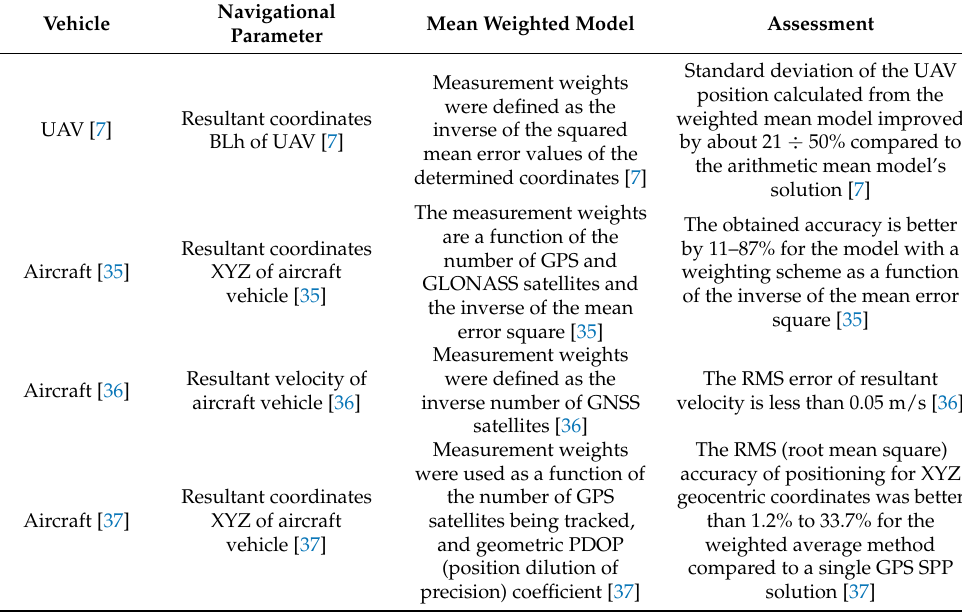
Table 1. The characteristic of the mean weighted model in research work in the aeronautical area. Navigational Vehicle Mean Weighted Model Assessment Parameter Standard deviation of the UAV Measurement weights position calculated from the were defined as the Resultant coordinates weighted mean model improved UAV [7] inverse of the squared by about 21 ÷ 50% compared to BLh of UAV [7] mean error values of the the arithmetic mean model’s determined coordinates [7] solution [7] The measurement weights The obtained accuracy is better are a function of the Resultant coordinates by 11–87% for the model with a number of GPS and Aircraft [35] XYZ of aircraft weighting scheme as a function GLONASS satellites and vehicle [35] of the inverse of the mean error the inverse of the mean square [35] error square [35] Measurement weights Resultant velocity of were defined as the Aircraft [36] aircraft vehicle [36] inverse number of GNSS satellites [36] The RMS (root mean square) Measurement weights accuracy of positioning for XYZ were used as a function of the number of GPS geocentric coordinates was better satellites being tracked, than 1.2% to 33.7% for the and geometric PDOP vehicle [37] weighted average method (position dilution of compared to a single GPS SPP solution